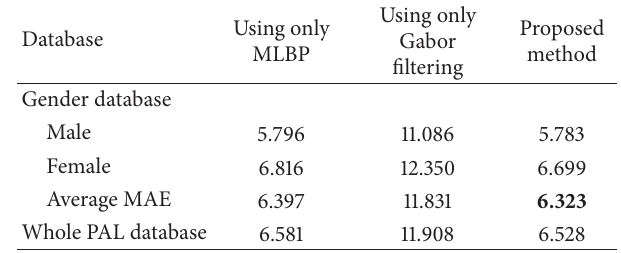
Table 6: The number of images used for the comparative experi- ments with/without the preclassification of gender.